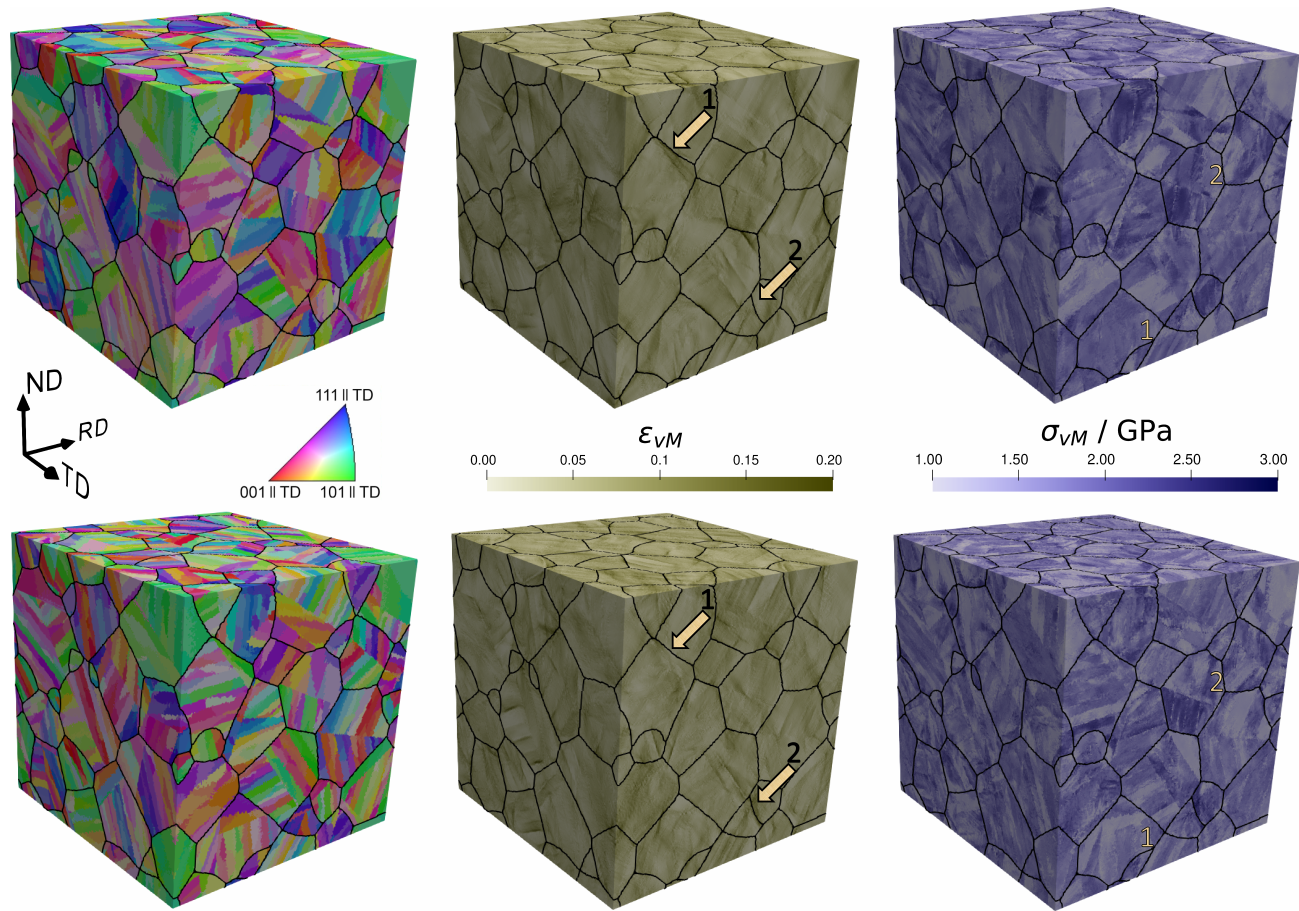
Figure 13. Inverse Pole Figure (IPF) and equivalent strain and stress distribution for an RVE with t subblock = 20 ( top ) and t subblock = 8 ( bottom